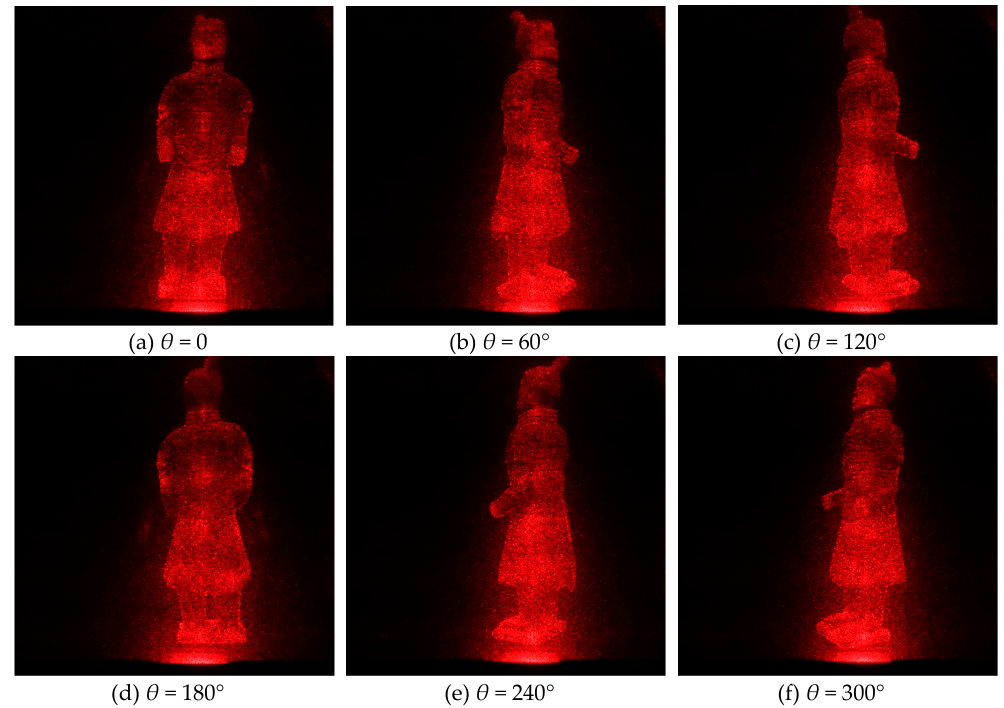
Figure 11. Electro-optical reconstructed images at di ff erent viewing angles with kinoform sequence scheme